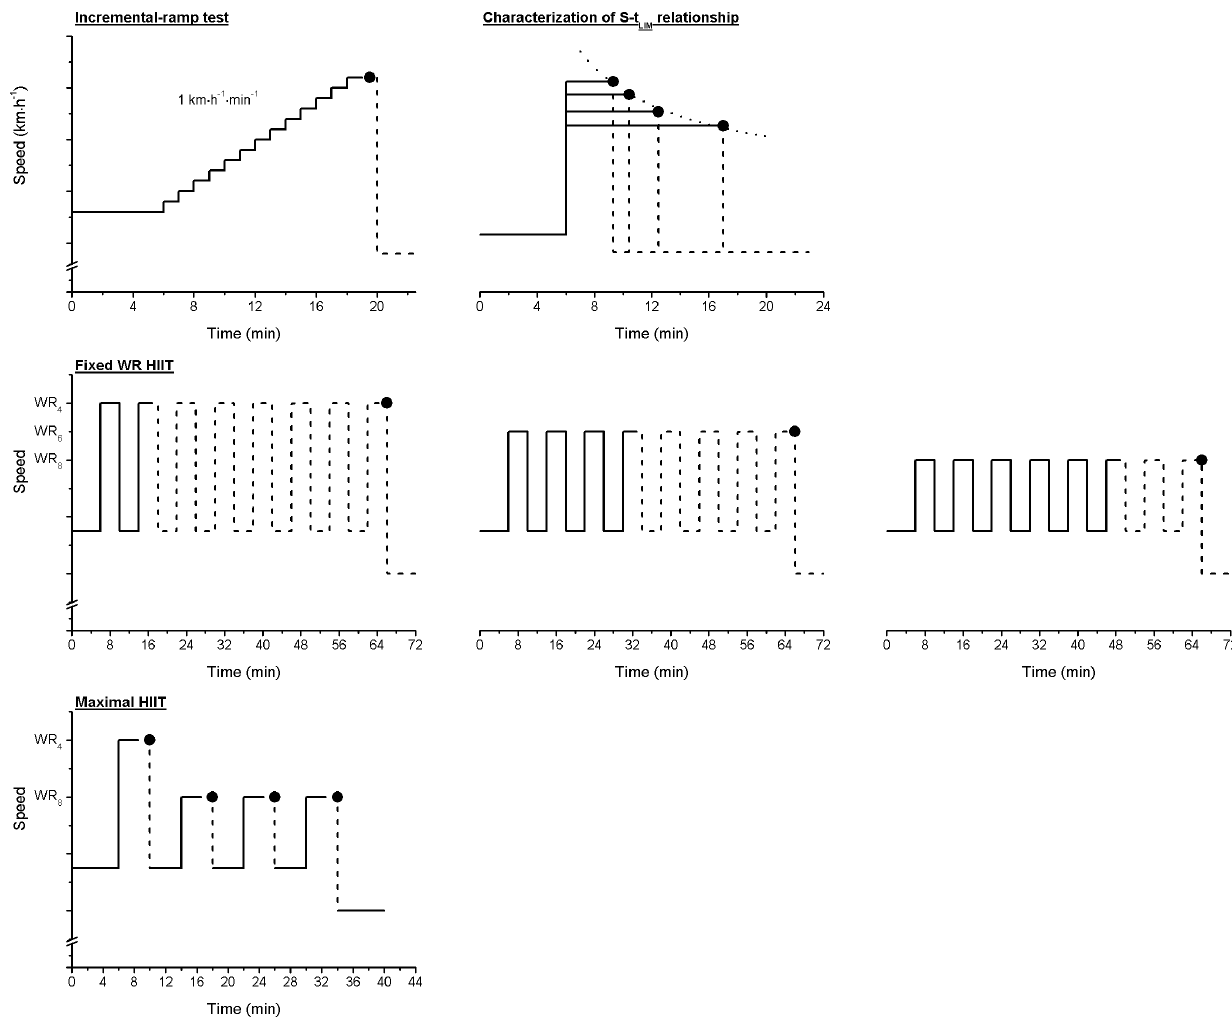
Figure 1. Schematic of the treadmill speed profiles performed during the Incremental-ramp test, the constant-speed tests for characterization of the Speed-tolerable duration (S-t LIM ) relationship – dotted line (top left and right respectively), the fixed HIIT protocols in which 4 min bouts at WR 4 , WR 6 or WR 8 were alternated with 4 min recovery bouts until the limit of tolerance was N attained (middle row), and the maximal HIIT protocol in which each bout was performed to the limit of tolerance, with a fixed represents the limit of exercise tolerance in all protocols. 4 min recovery between each bout (bottom).